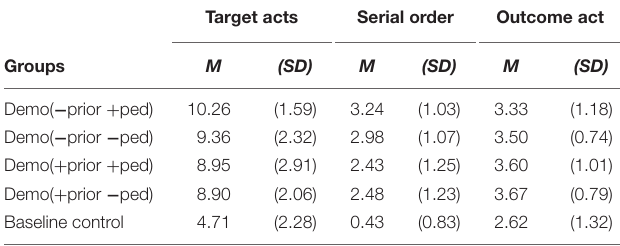
TABLE 2 | Mean ( SD ) of dependent measures as a function of test